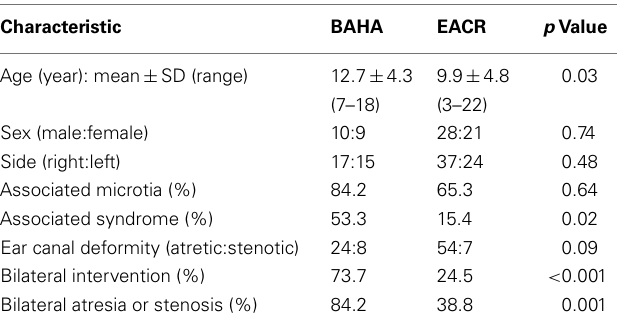
Table 1 | Comparison of demographic information between the EACR and BAHA groups .